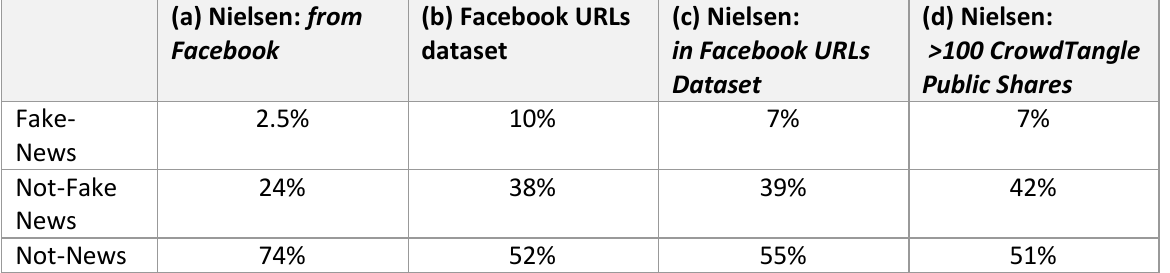
Table 1. Estimated percentage of clicks on Facebook for fake news, not-fake news, and not-news under various data and assumptions in December